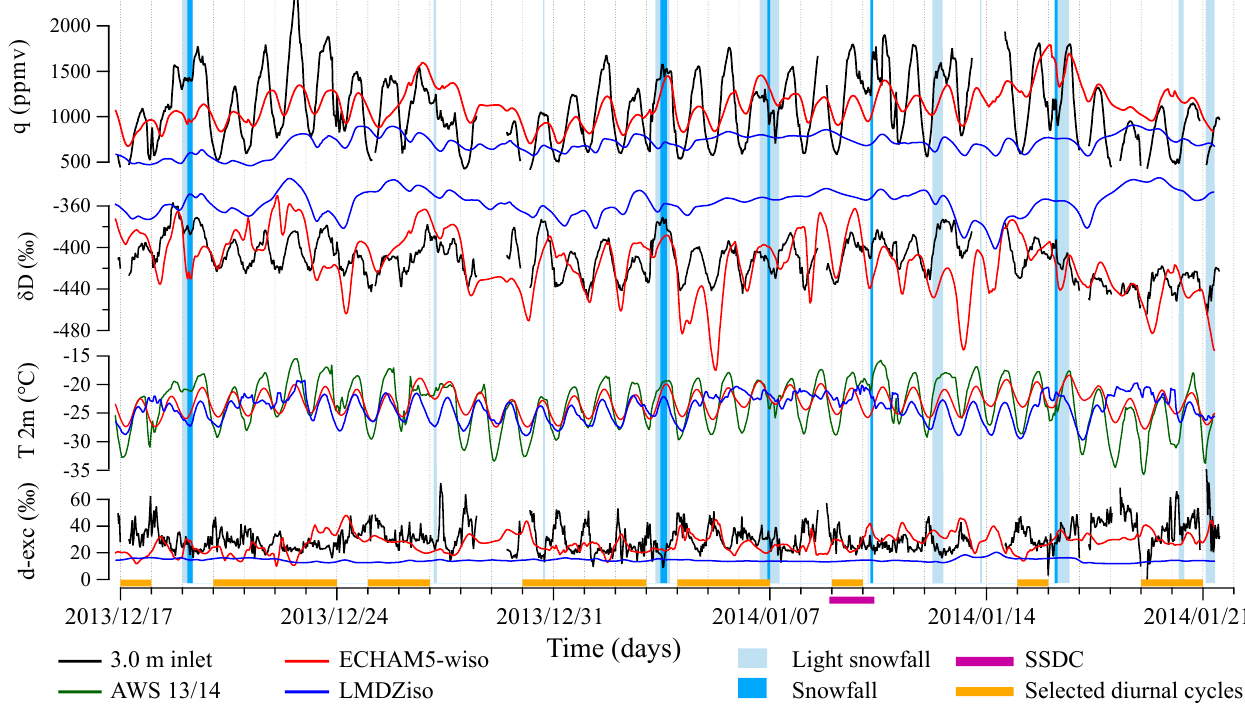
Figure 2. Hourly observed (black and green) and simulated (red and blue) humidity mixing ratio ( q ), deuterium ( δ D), air temperature at 2m ( T 2m, measured with the AWS from the 2013/2014 season) and d-excess (d-exc) at Kohnen station 2013/2014. Hourly observed precipitation events are labeled light snowfall and snowfall (light and dark cyan). The Snow Surface Diurnal Cycle (SSDC) experiment period is indicated in purple, and the 18 selected days for the diurnal cycles study are in